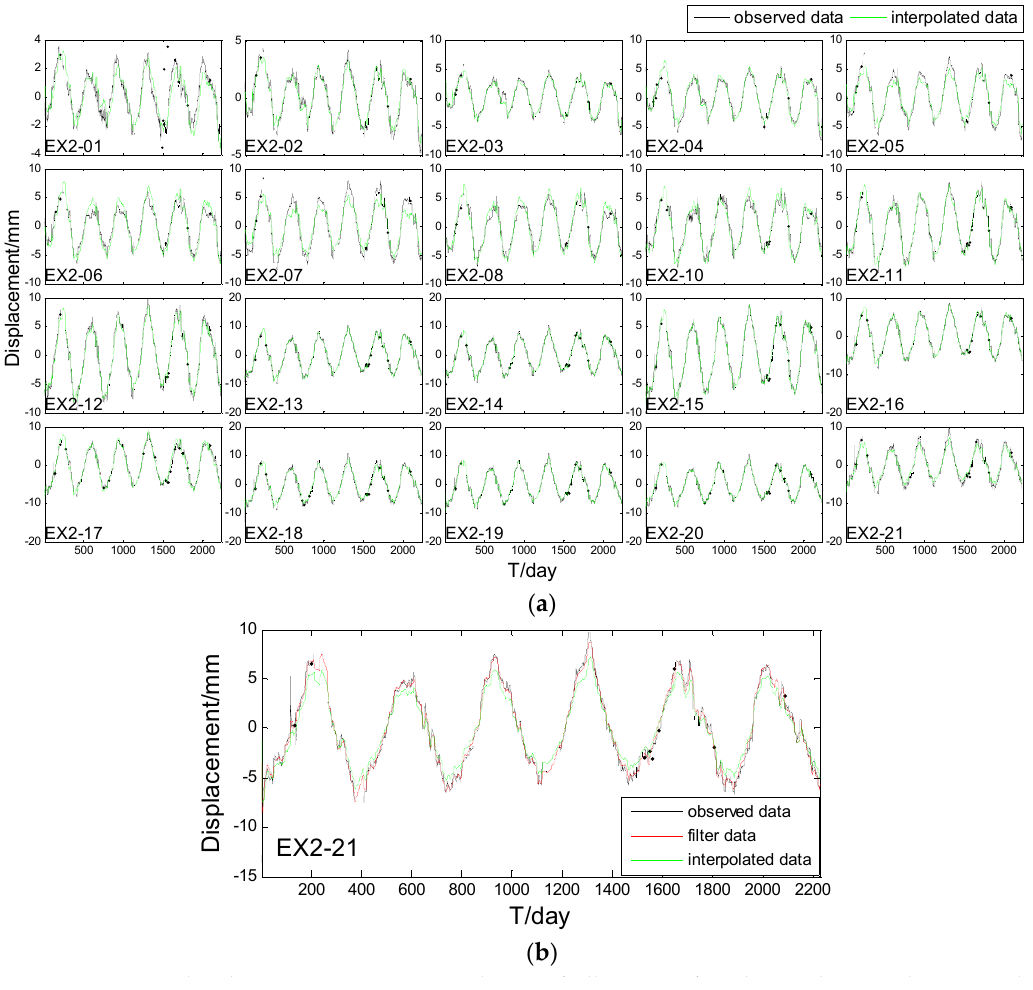
Figure 7. Interpolated time series. ( a ) Interpolation of all points; ( b ) Filter and interpolation results of EX2_21.